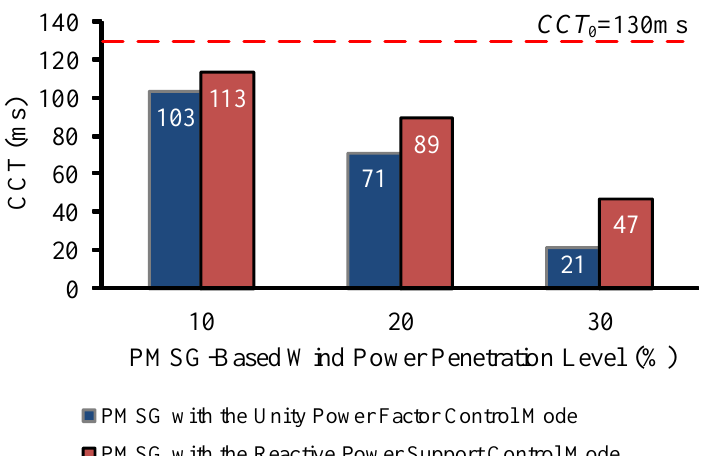
Figure 12. Critical clearing times (CCTs) of the fault on line 7–8 in the scenarios of PMSG-based wind power balanced by G1.